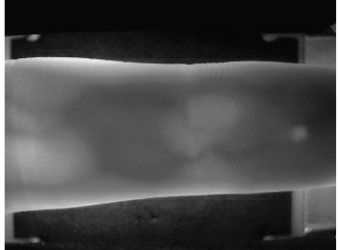
Figure 9. Vein image from the SDUMLA-HMT dataset [19].